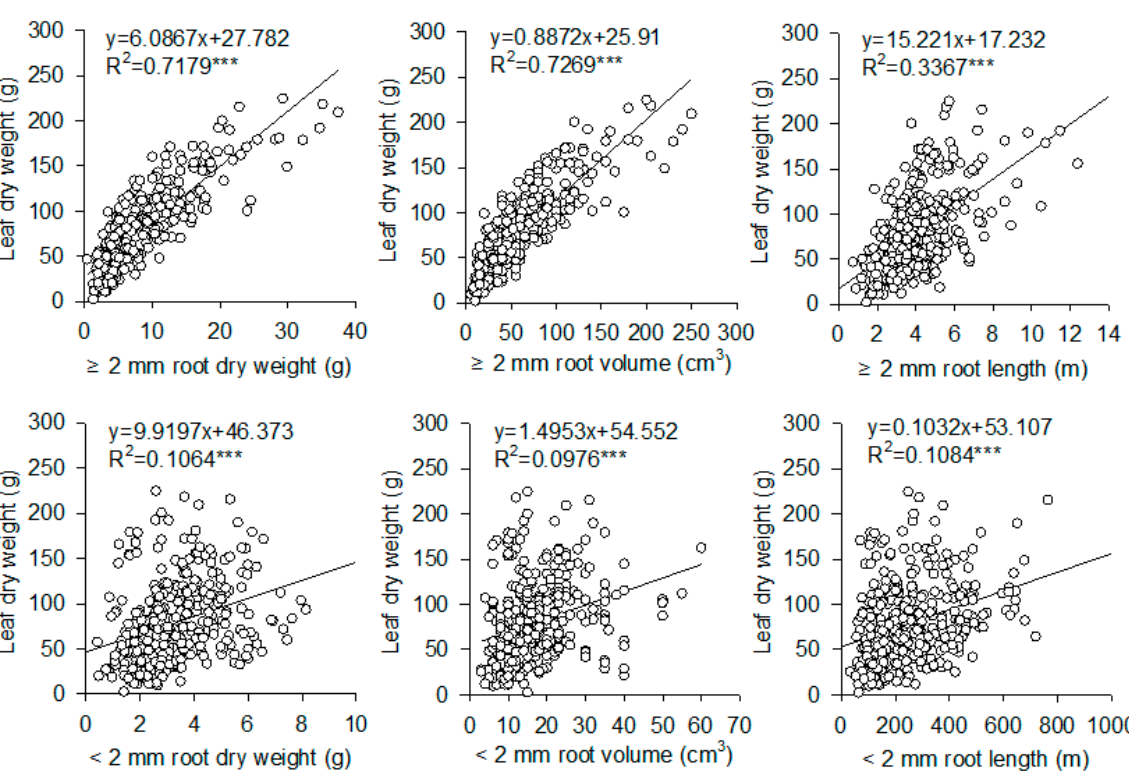
Figure 2. Regression between the leaf dry weight and root-knot dry weight, volume, and number. n = 360.